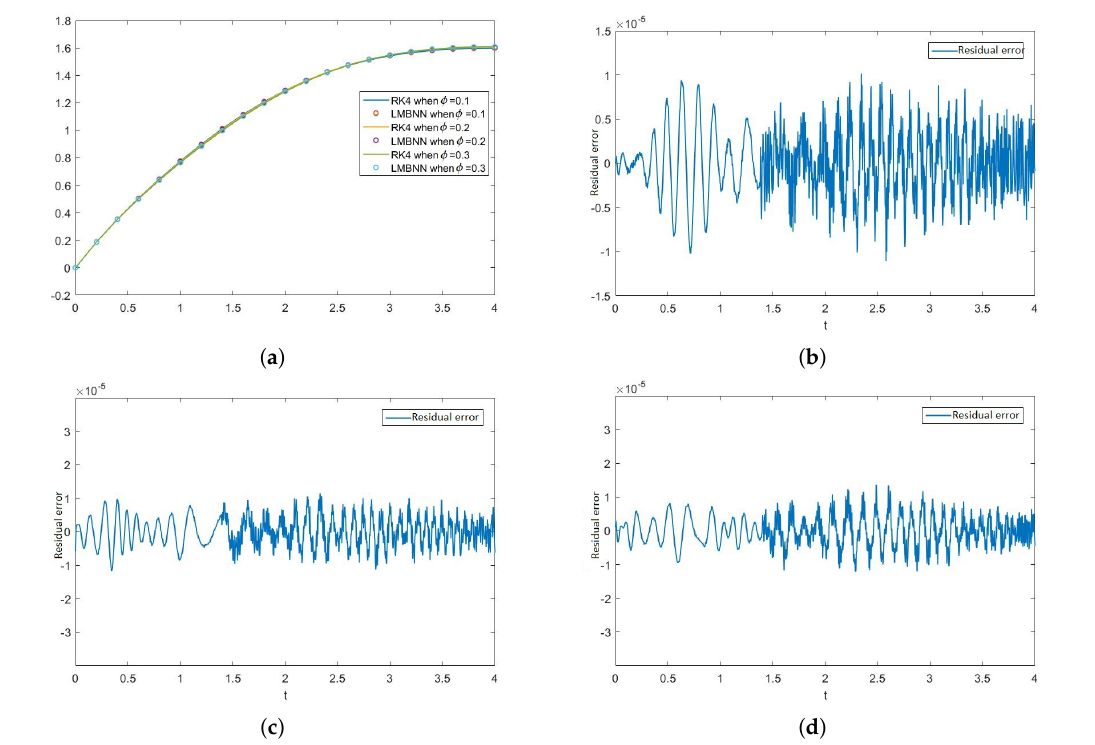
Figure 12. Graphical illustration of F and the residual error graphs in the outputs of RK4 and LMBNN when φ varies. ( a ) Numerical outputs of F when K varies. ( b ) Error in F when φ = 0.1. ( c ) Error in F when φ = 0.2. ( d ) Error in F when φ = 0.3.